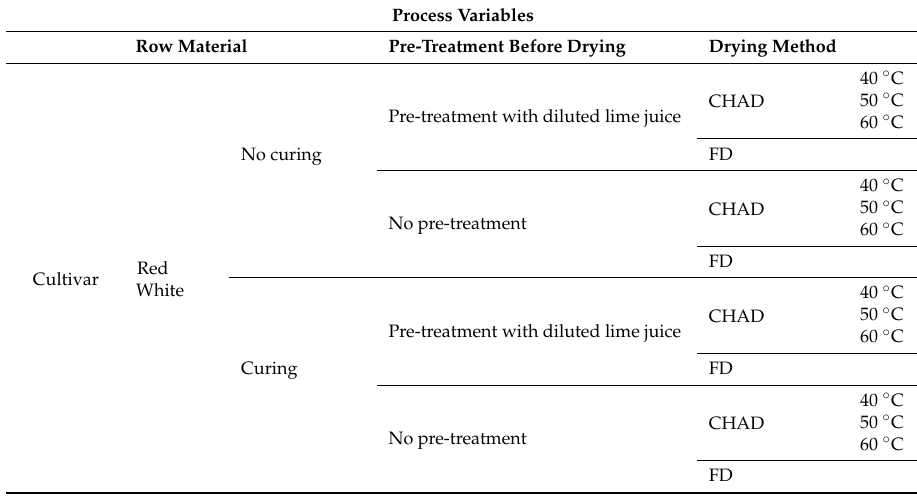
Table 1. Process variables for drying of yacon